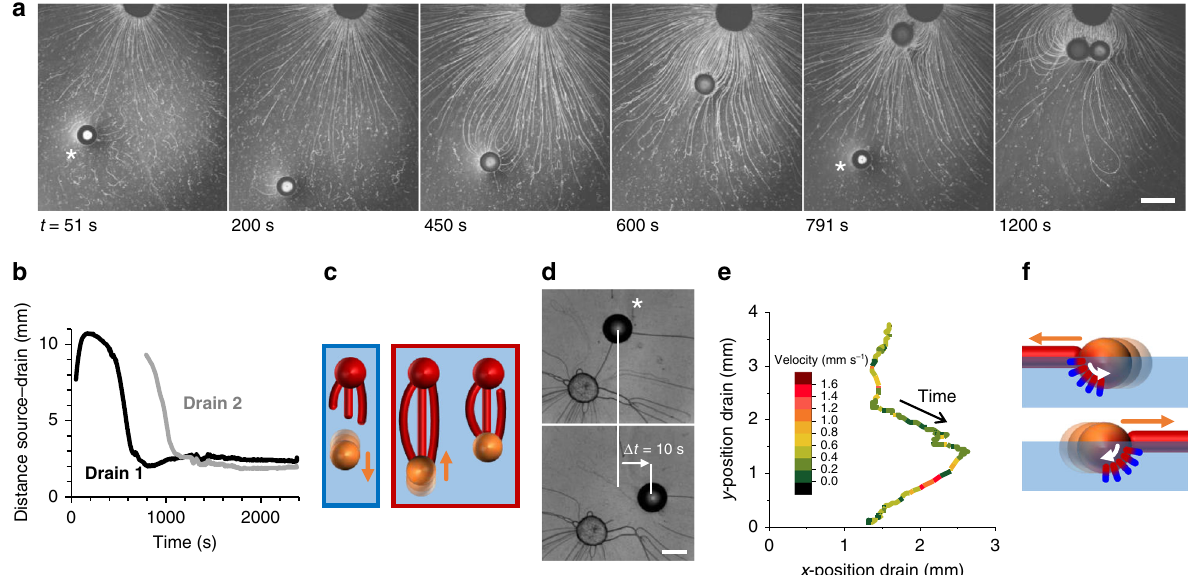
Fig. 3 Filament absorption generates attractive forces at the drain droplet. a Optical microscopy recording after subsequent deposition of source droplet ( t = 0 s) and two 10 wt% sodium oleate in oleic acid drain droplets, indicated with asterisks, deposited at t = 51 and 791 s. b Distance source – drain vs. time, for both drain droplets in a . c Schematic representation of the self-organization, emerging from a balance between the Marangoni fl ow that repels the drain droplet (blue box), and fi lament absorption that generates attractive forces (red box). d Optical microscopy recording of a source and oleic acid drain droplet (asterisk) where the Marangoni fl ow from the source to the drain was suppressed by the inclusion of C 12 E 4 OH in the aqueous phase. Upon absorption of a fi lament, the drain moved abruptly, over the course of Δ t = 10 s, into the direction where the absorption took place, as shown by the x - and y -position (with respect to the source) of the drain droplet in e . f Upon absorption, the fi lament provides a non-uniform distribution of surfactants at the oil – water interface, driving an internal Marangoni fl ow that propels the droplet towards the absorption site. The scale bars represent 2 mm ( a ) and 1 mm ( d ),